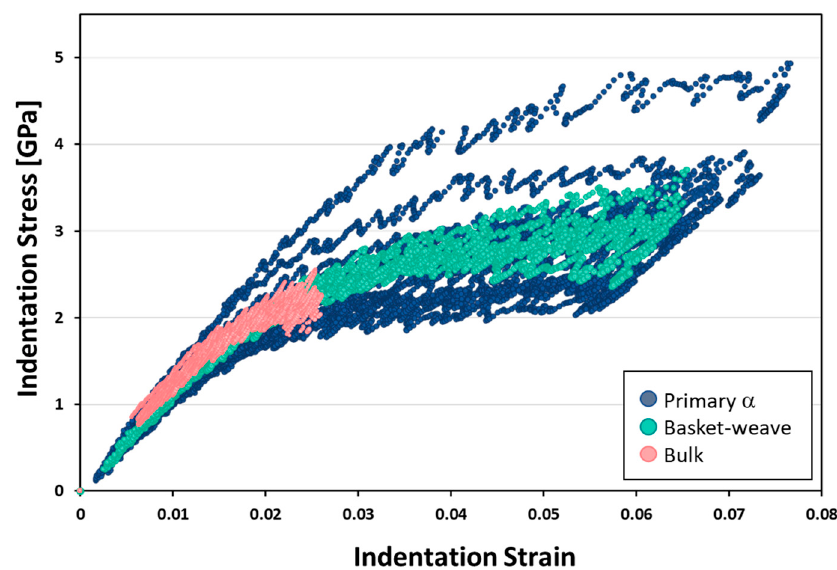
Figure 4. Examples of the indentation stress-strain curves measured in this study. The blue curves are from measurements on primary a grains, the green curves are from basket-weave grains, and the pink curves are bulk measurements.